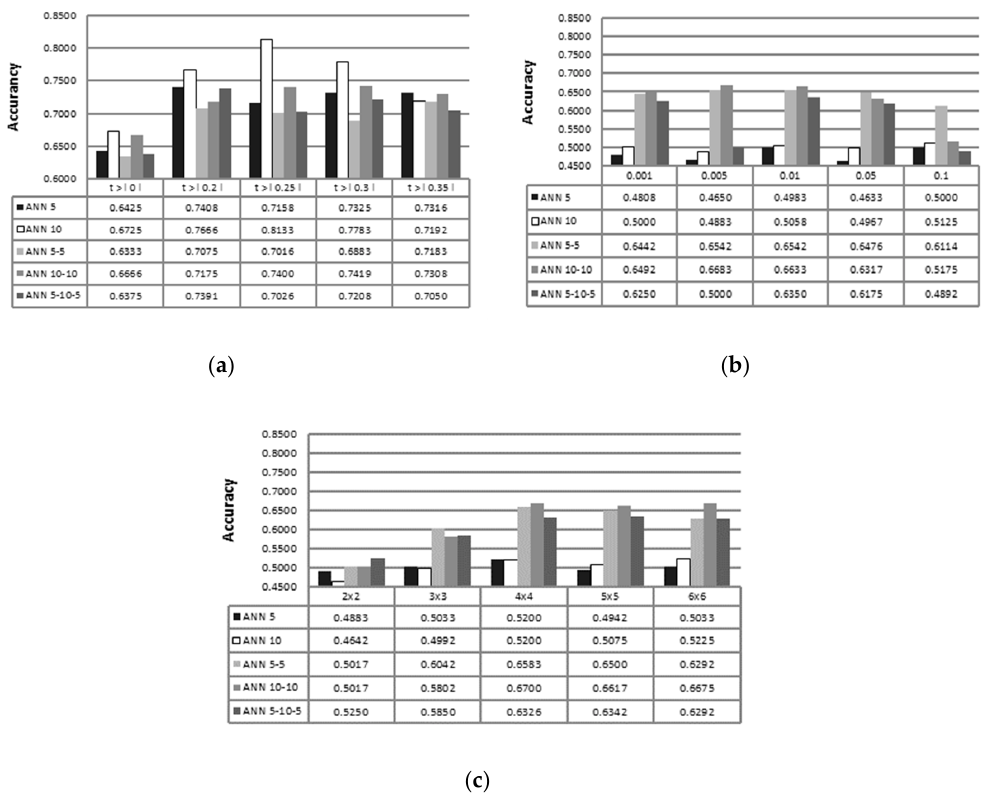
Figure 4 . Test set accuracy of Kendall’s ( a ), PCA ( b ), and SOM based feature selection ( c ) with ANN 5, ANN 10, ANN 5-5, ANN 10-10, and ANN 5-10-5 configurations